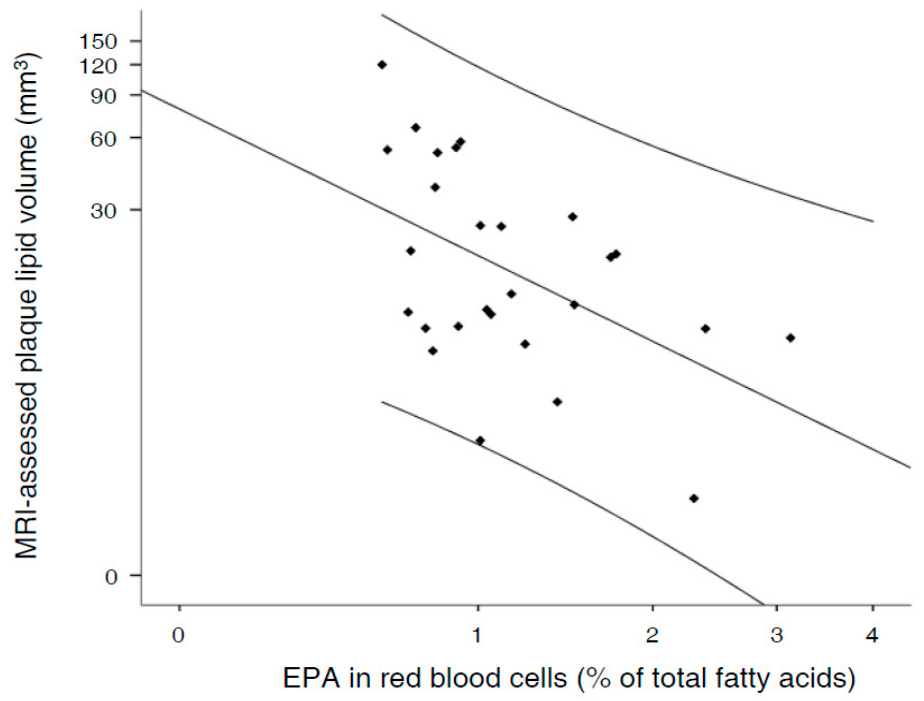
Figure 2. Scatter plot of the red blood cell proportion of EPA and plaque lipid core burden.